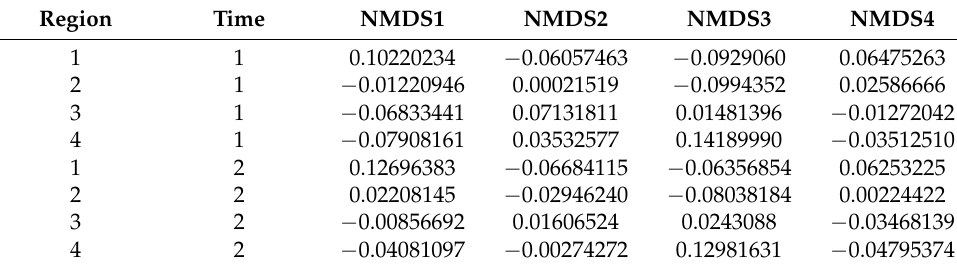
Table A5. Region/time (“site”) scores based on average scores for individual